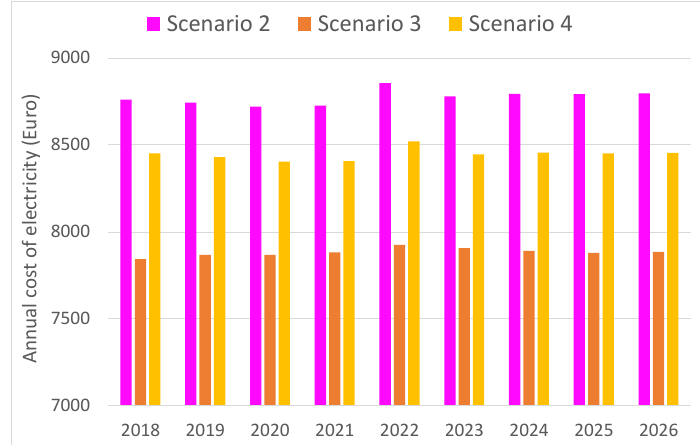
Figure 11. Annual electricity cost of the heat pump in simulated retrofit solutions from 2018 to 2026.